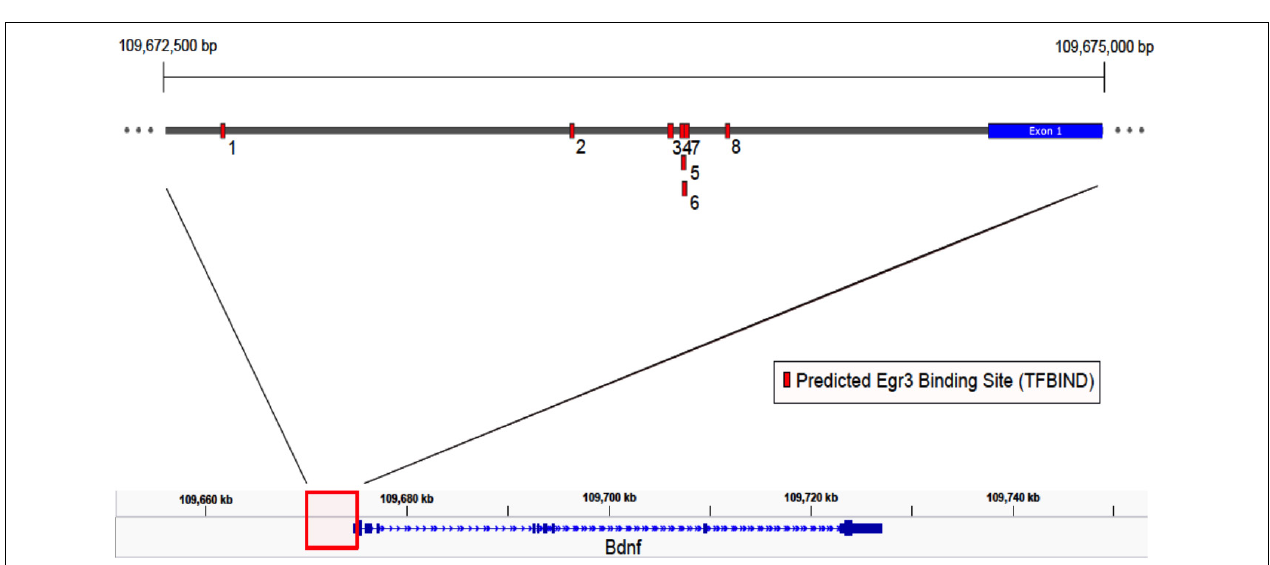
FIGURE 4 | Map of predicted EGR3 binding sites in Bdnf upstream region. EGR3 binding sites identified in Table 1 are indicated in red. Positions are shown relative to exon 1 of the mouse Bdnf gene as identified in the NCBI Refseq database. Numbers under each binding site correspond to numbered rows in Table 1 .